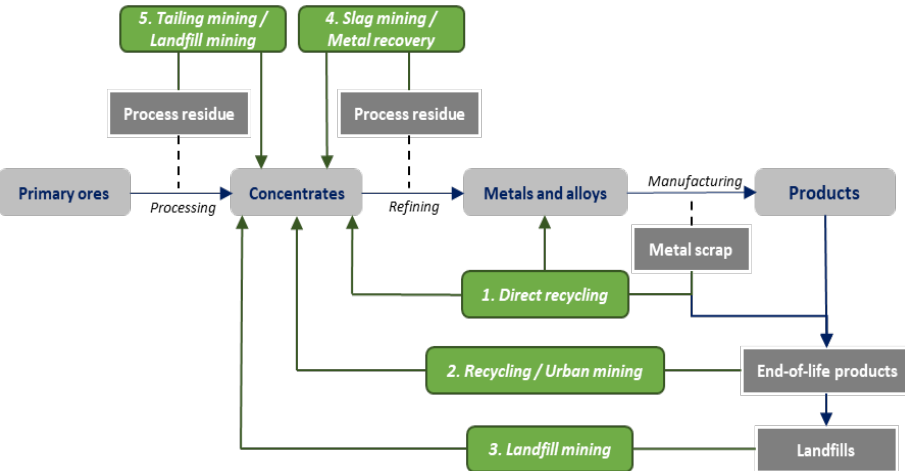
Figure 1. Technospheric mining of mining wastes (adapted from Binnemans et al. [9]).